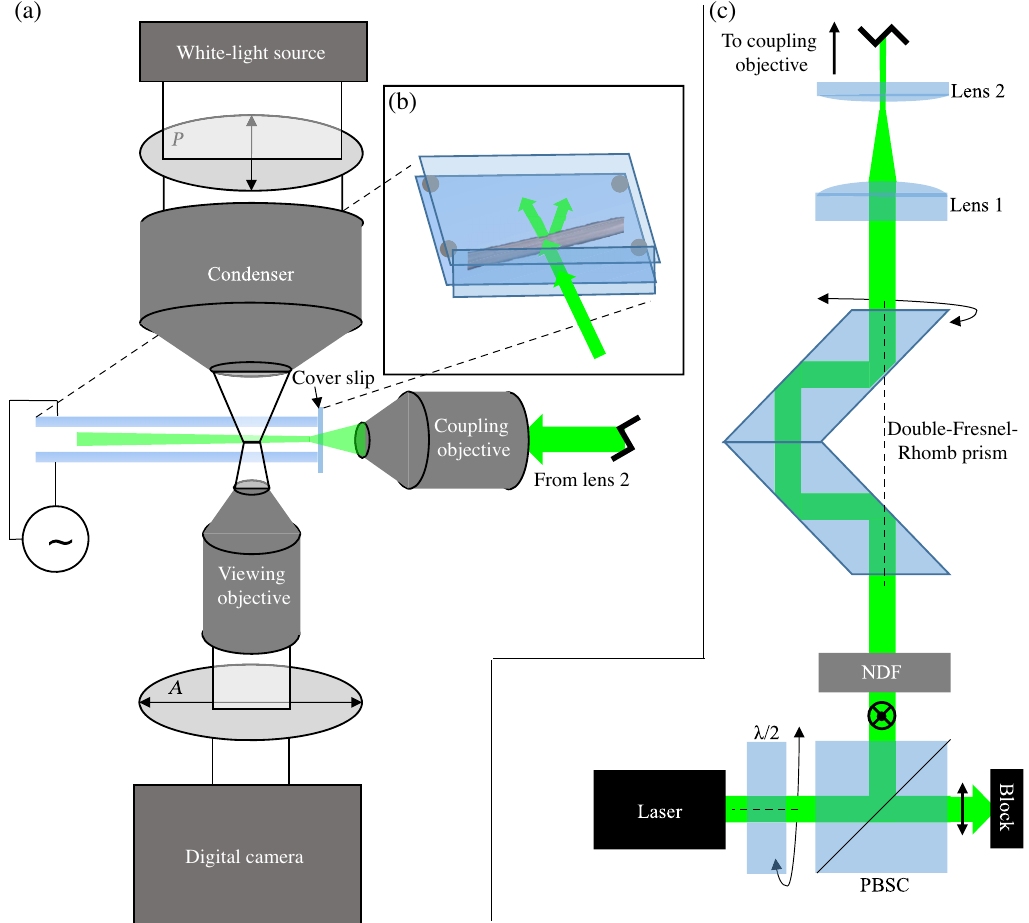
FIG. 2. Schematics of the (a) microscope, (b) liquid-crystal cell, and (c) optical setup used to probe interactions between Gaussian beams and topological solitons in frustrated cholesteric LCs. (Not to